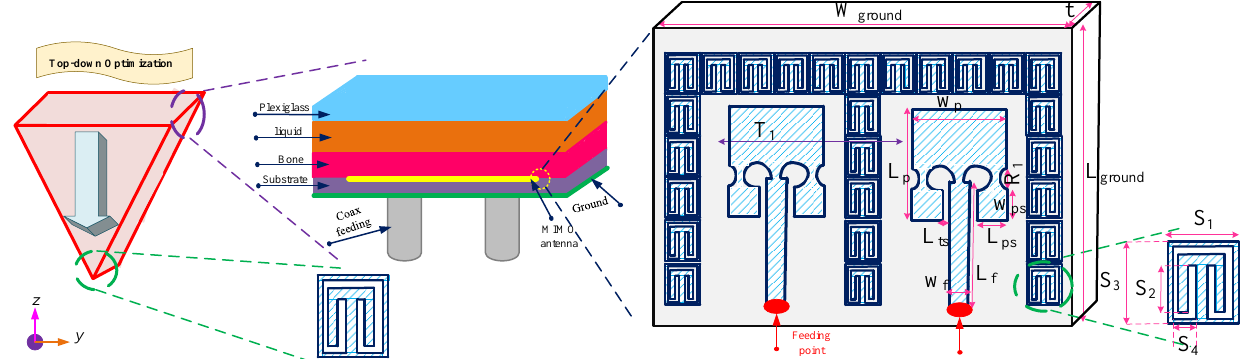
Figure 1. Comprehensive graphical representation of the proposed method.